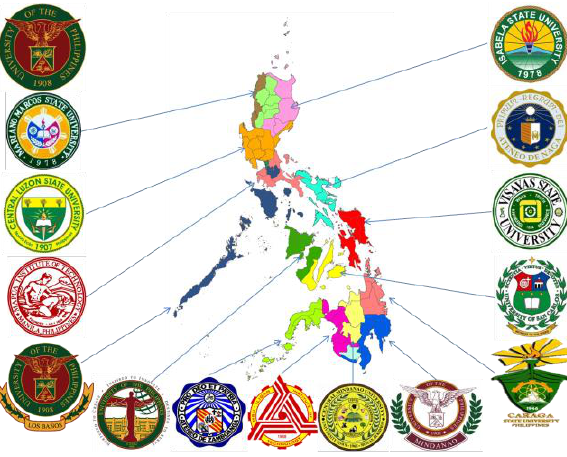
Figure 3. The Phil-LiDAR 2 implementing institutions and their respective assigned provinces and regions of the Philippines